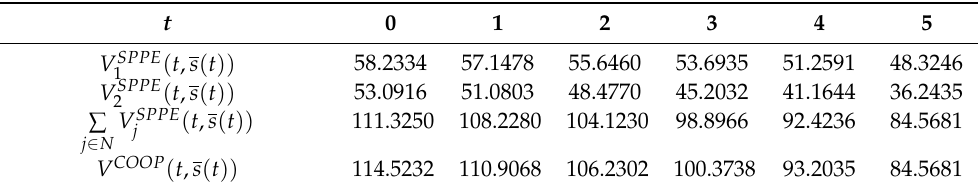
Table 4. The players’ SPPE payoffs versus cooperative payoff in the subgames along the coopera- tive trajectory.